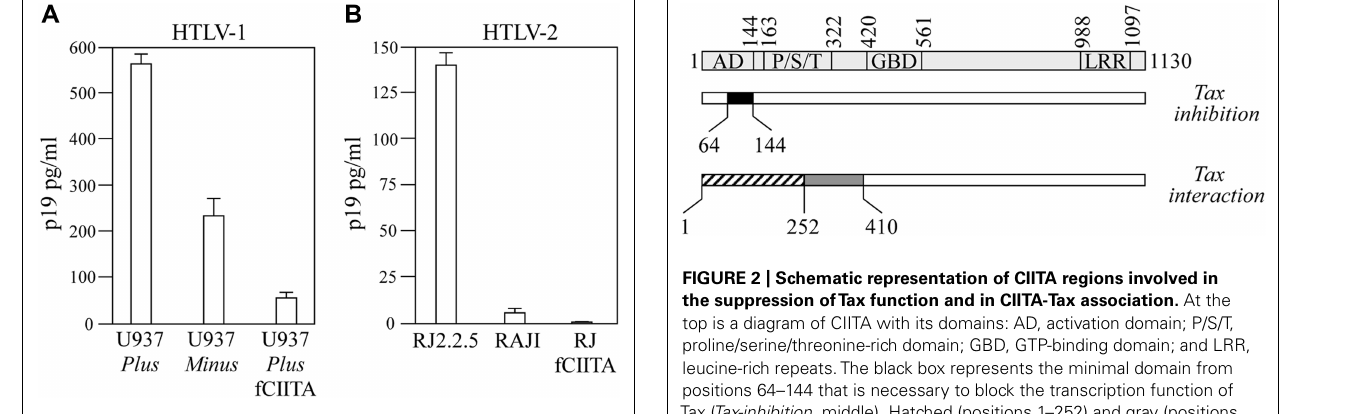
FIGURE 1 | Endogenous CIITA inhibits both HTLV-1 and HTLV-2 gene expression. (A) CIITA-negative U937 plus clone, CIITA-positive U937 minus clone, and U937 plus clone stably expressing fCIITA (U937 plus fCIITA) were transfected with the pACH plasmid containing the entire HTLV-1 genome.The amount of HTLV-1 p19 antigen (pg/ml) in cells supernatants was detected by enzyme-linked immunoassay (ELISA) 48 h post-transfection. Error bars indicate standard deviations. Derived fromTosi etal. (2011). (B) CIITA-positive Raji cells, their CIITA-negative isogenic mutant RJ2.2.5, and the RJfCIITA cells stably transfected with CIITA were infected with the HTLV-2 Gu strain 2b and the productive infection was evaluated by the presence of HTLV-2 p19 antigen (pg/ml) in cell culture supernatants measured by (ELISA). Error bars indicate standard deviations. Derived from Casoli etal. (2004).